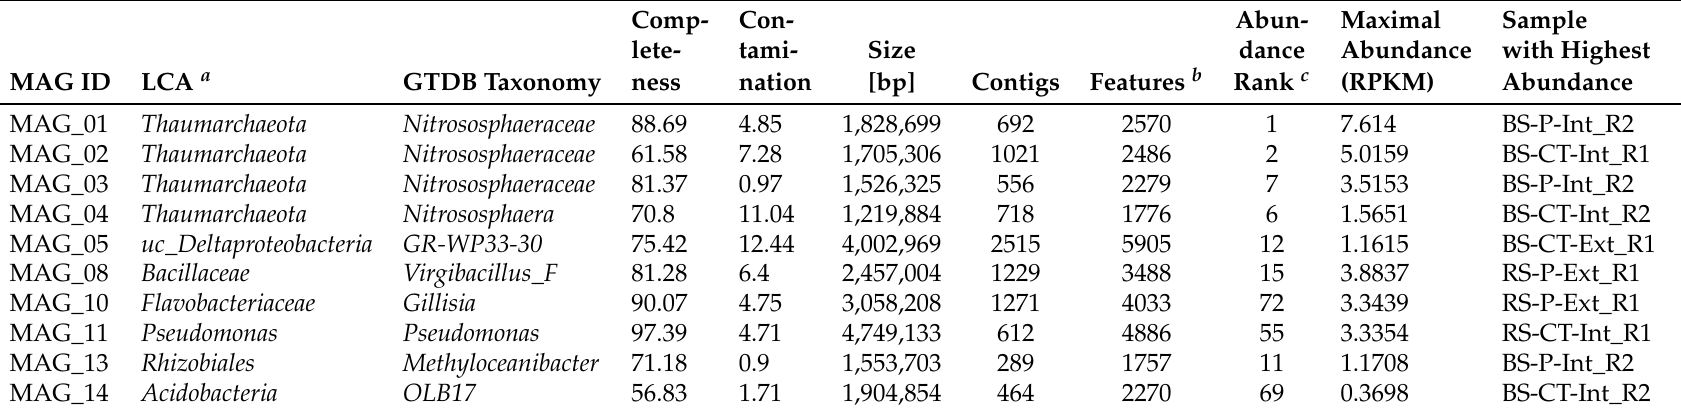
Table 2. Summary of high-quality Metagenomically Assembled Genomes (MAGs) compiled from metagenomic sequences of LTE-1 soil